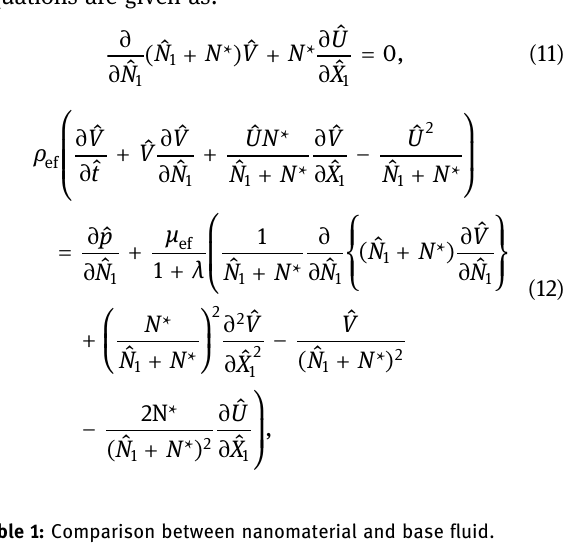
Table 1: Comparison between nanomaterial and base fl